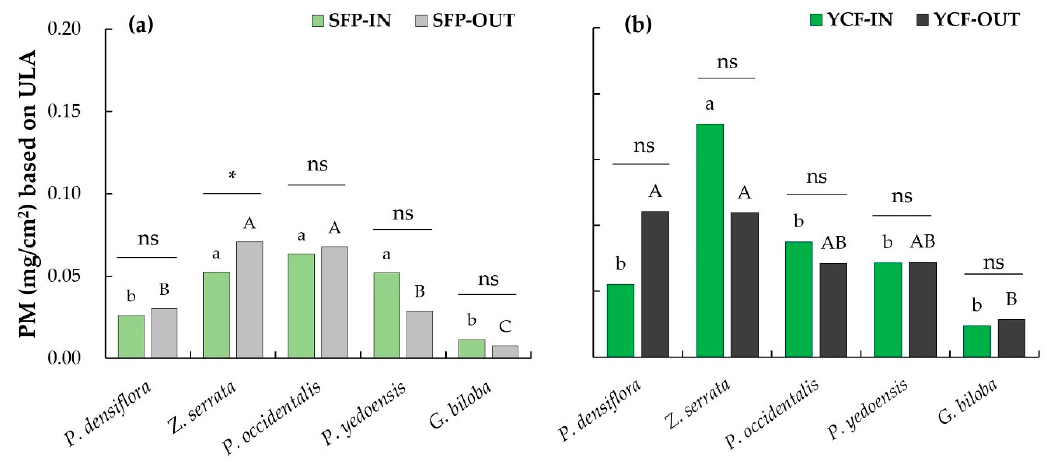
Figure 3. Comparison of the capacity to capture airborne PM particles on a per unit leaf area basis (ULA) of five tree species in urban forests and roadsides of ( a ) Seoul Forest Park (SFP-IN, SFP-OUT) and ( b ) Yangjae Citizen’s Forest (YCF-IN, YCF-OUT). Each bar represents the mean of nine replicates. Light green bars, SFP-IN; grey bars, SFP-OUT; green bars, YCF-IN; black bars, YCF-OUT. Di ff erent lowercase letters mean significant di ff erences among tree species within each SFP-IN and YCF-IN, while di ff erent uppercase letters mean significant di ff erences among tree species within each SFP-OUT and YCF-OUT (Duncan’s multiple range after one-way ANOVA). Asterisks represent significant di ff erences between urban forests and roadsides (i.e., SFP-IN and SFP-OUT; YCF-IN and YCF-OUT) within each site (paired t -test, * p < 0.05; ** p < 0.01; *** p < 0.001; ns, not significant).